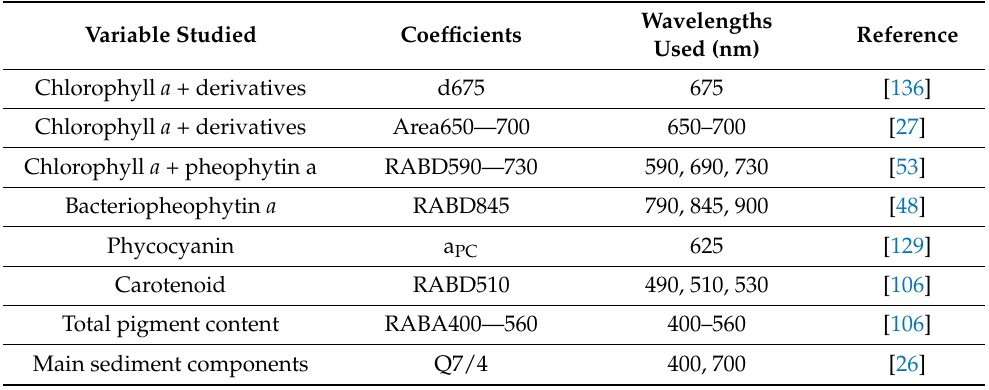
Table 3. Some spectroscopic pigment coefficients for the ultraviolet, visible, and near-infrared spectral ranges reported in the literature for different samples (sediments, rock, soil and